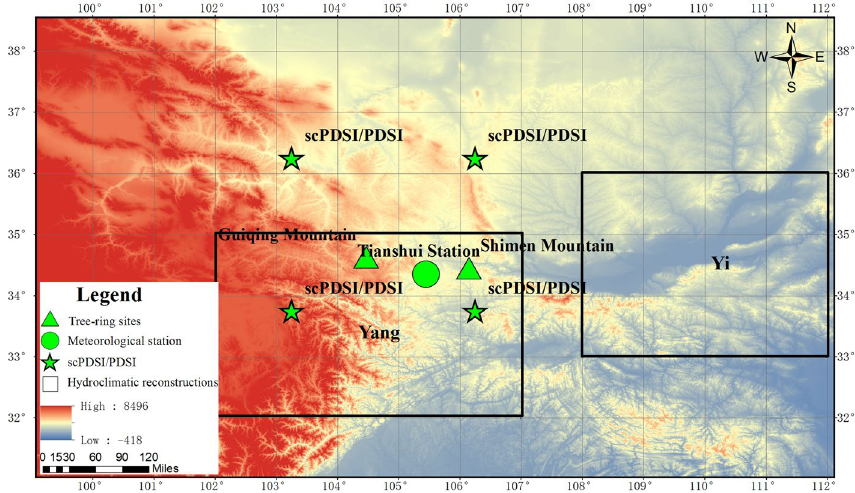
Figure 12. Locations of the sampling site, meteorological stations and comparison sites. Map is created using ArcGIS10.2 software for the ArcGIS Free Trial (https:// lzuedu. maps. arcgis.